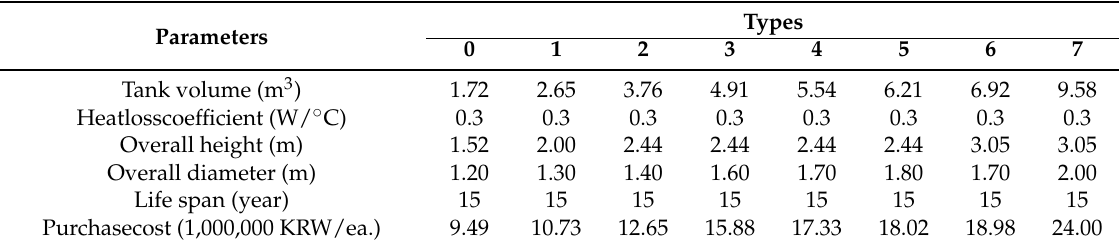
Table A3. Technical and economic parameters of storage tanks for case study.